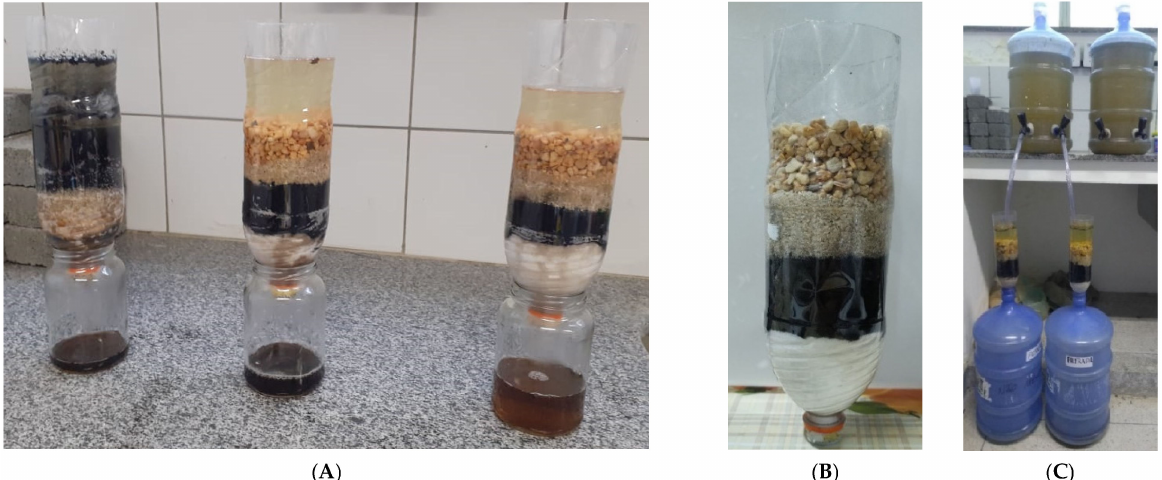
Figure 1. Filtration systems: ( A ) test of filtration systems for use in the experiment; ( B ) filtration system used in the post-treatment of domestic wastewater; ( C ) structure used in the post-treatment of domestic